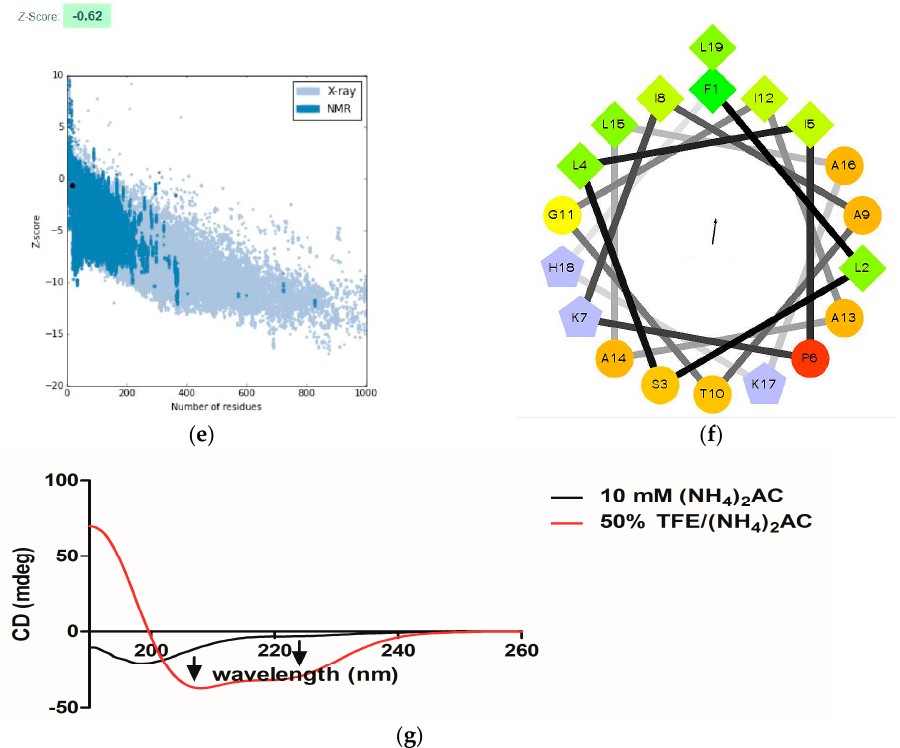
Figure 4. ( a ) The RP-HPLC chromatogram of the purified synthetic phylloseptin-PC (PSN-PC); ( b ) MALDI-TOF mass spectrum of synthetic PSN-PC; ( c ) Predicted secondary structure of PSN-PC using I-TASSER; ( d ) Predicted 3D model of PSN-PC using I-TASSER; ( e ) Z-score plot using ProSA-web; ( f ) Helical wheel plot of PSN-PC; ( g ) Circular dichroism (CD) spectra recorded for PSN-PC (100 µM) in 10 mM ammonium acetate buffer and 50% TFE ammonium acetate buffer.